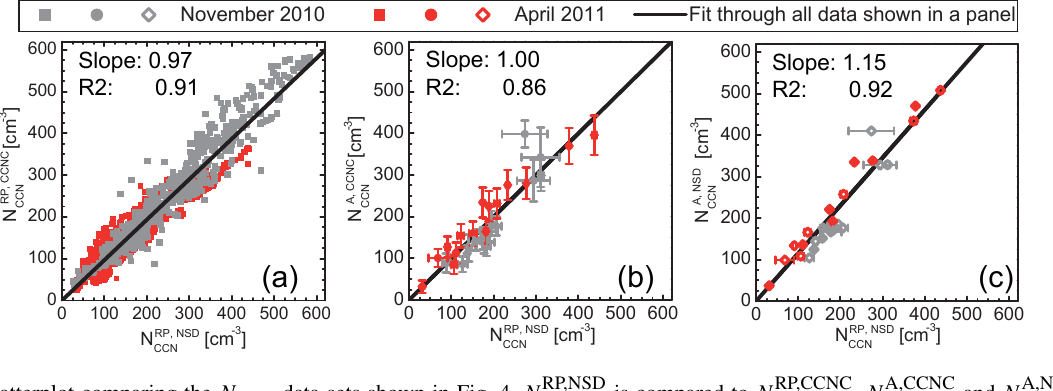
is compared to N RP,CCNC , N A,CCNC and N A,NSD in the CCN CCN CCN CCN CCN